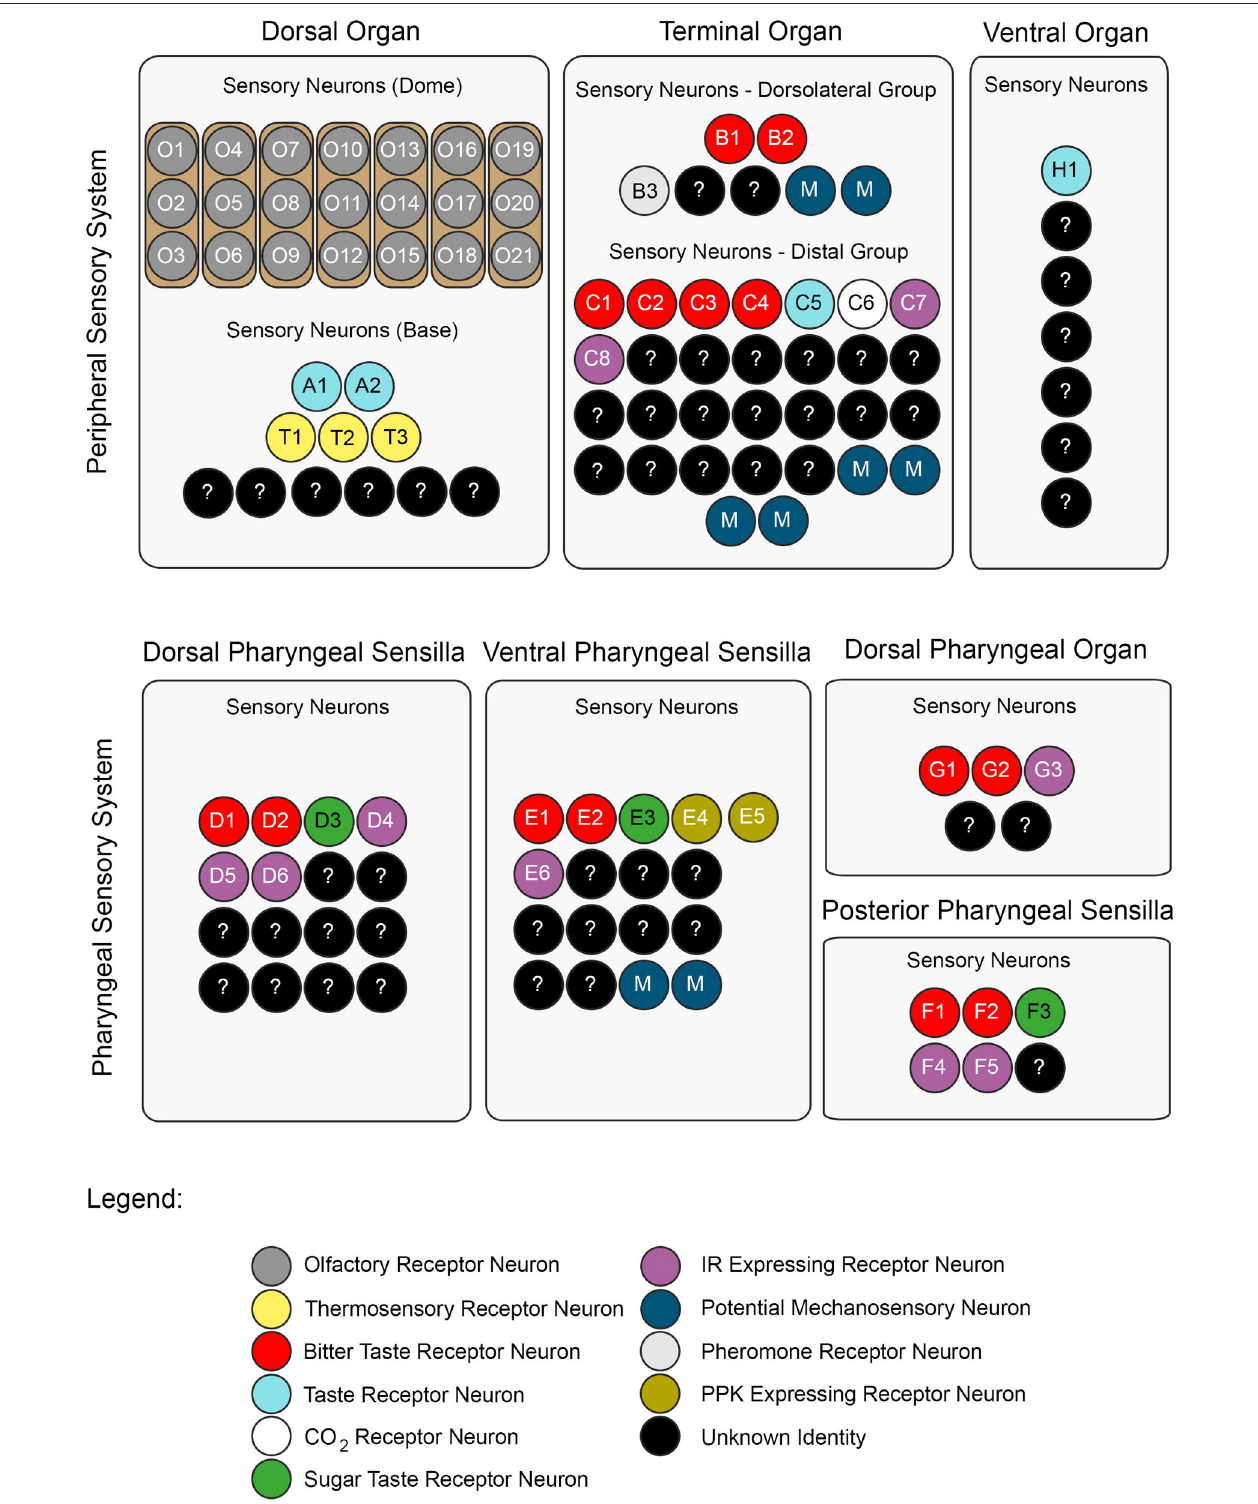
FIGURE 2 | A neuronal map of the larval taste system. The neuronal map defines the single neurons of the larval taste system based on their molecular and functional properties. The peripheral chemosensory system of the larva consists of three major external organs. The DO dome comprises 21 olfactory sensory